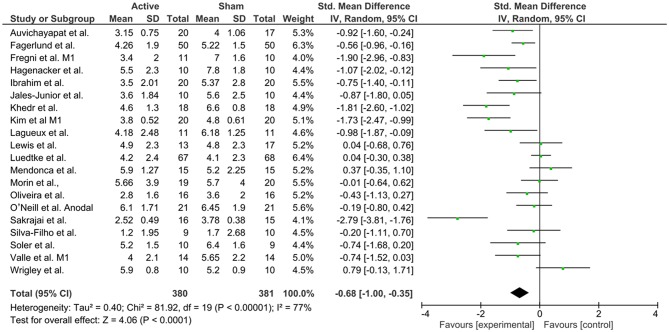
Forest plot of the effects of anodal M1 tDCS on pain levels (n = 20).